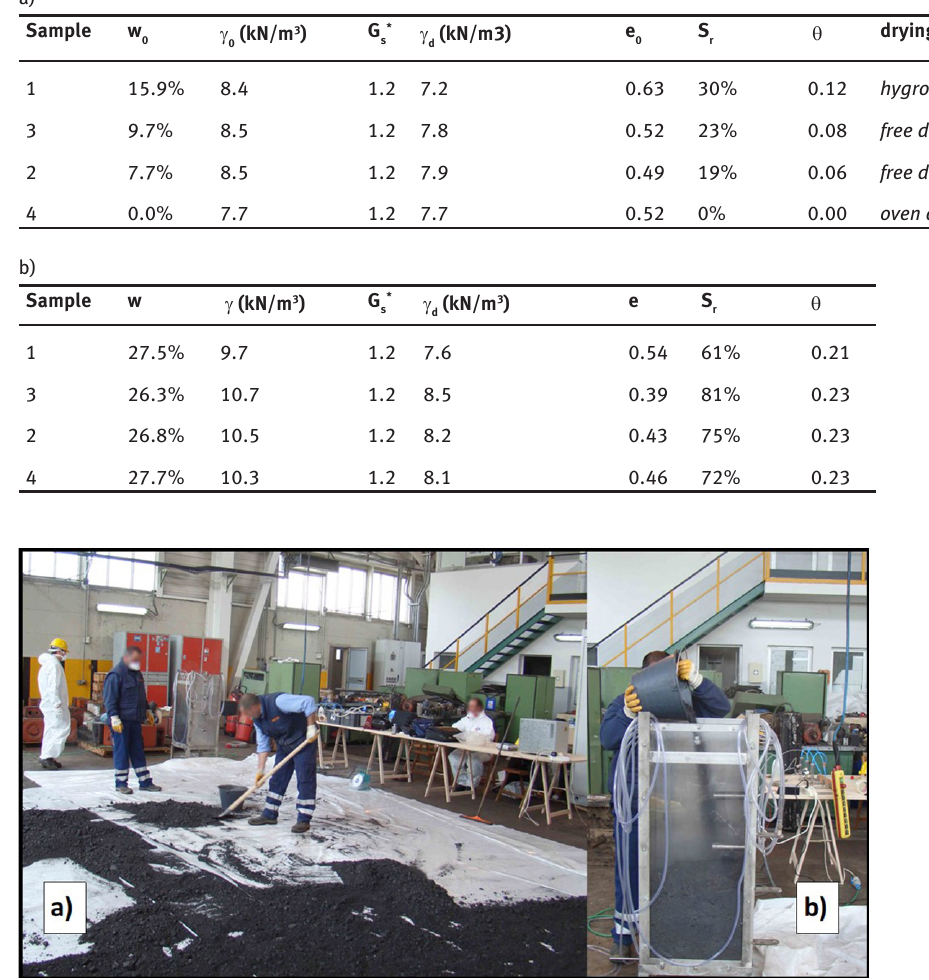
Figure 5: a) View of coal during drying at room temperature; b) phase of prototype